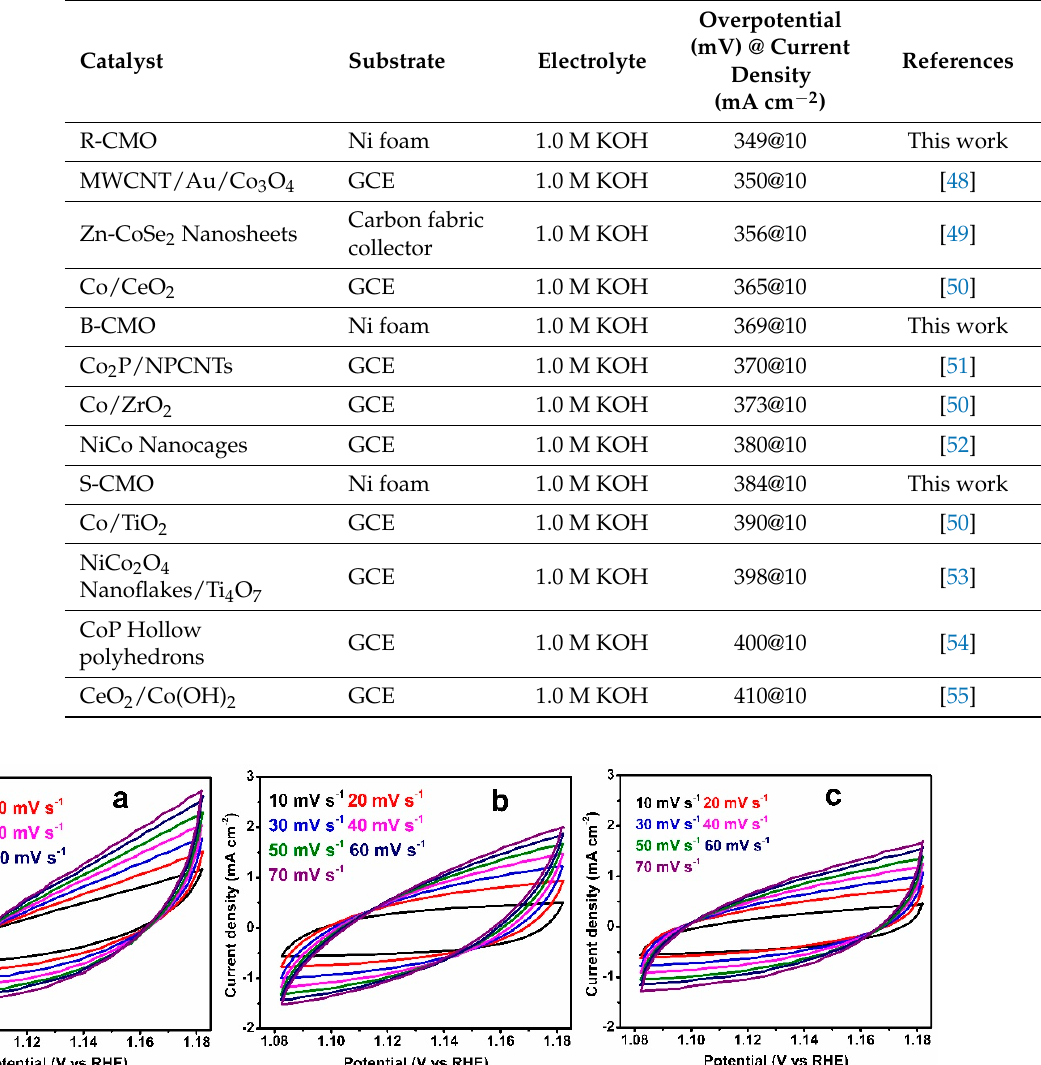
Table 1. Comparison of OER performance of present work with some of the representative non-noble catalysts.